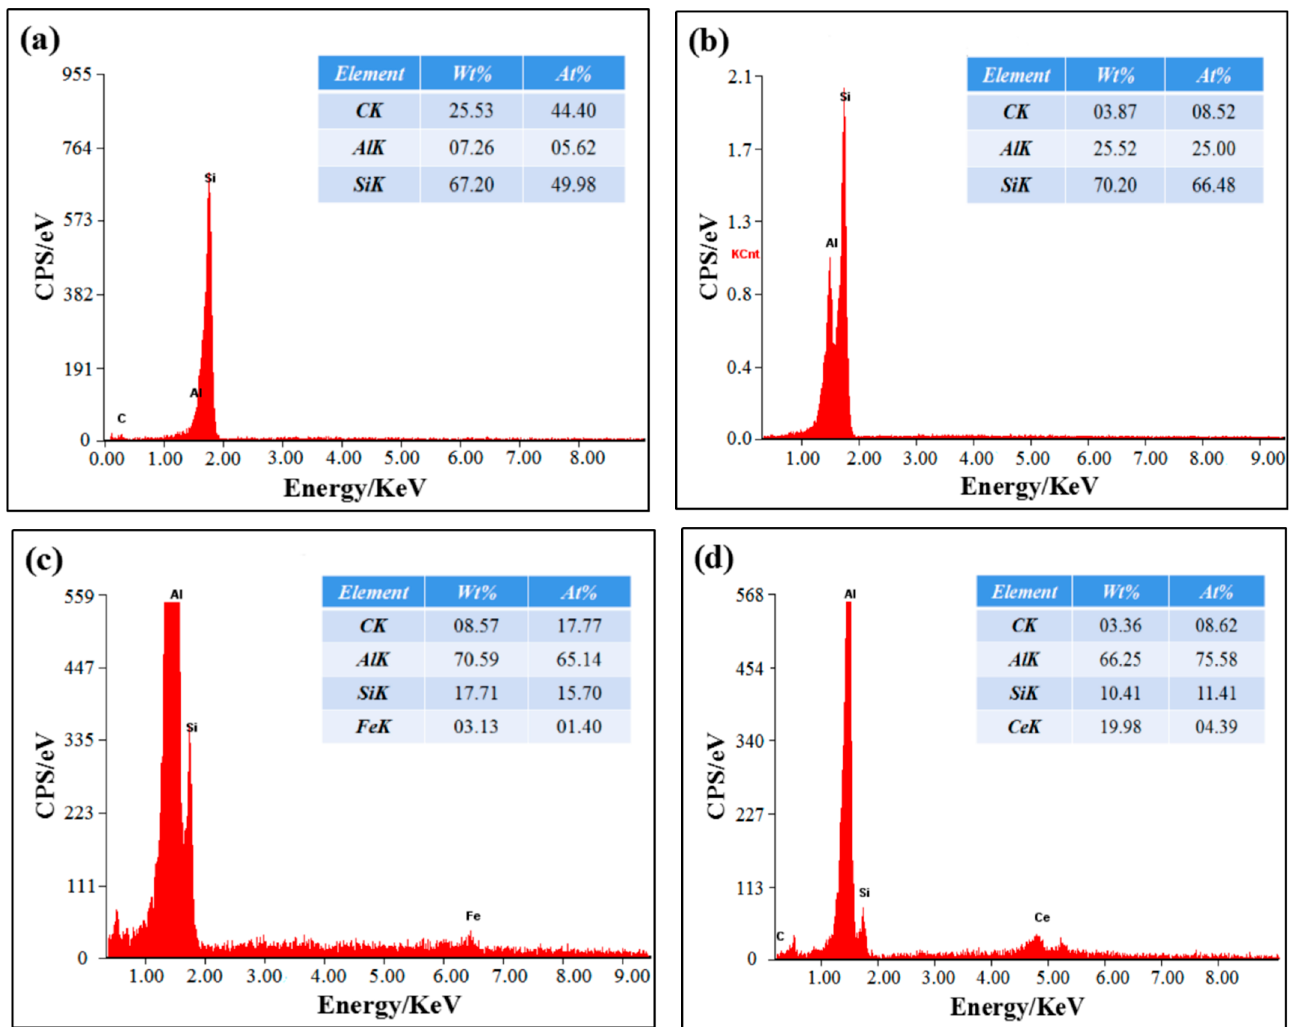
Figure 3. The energy spectrum diagram of SiCp/Al-Si composites with different CeO 2 volume fraction: ( a ) the EDS analysis of region A in Figure 2a; ( b ) the EDS analysis of region B in Figure 2a; ( c ) the EDS analysis of region C in Figure 2a; ( d ) the EDS analysis of region D in Figure 2b.